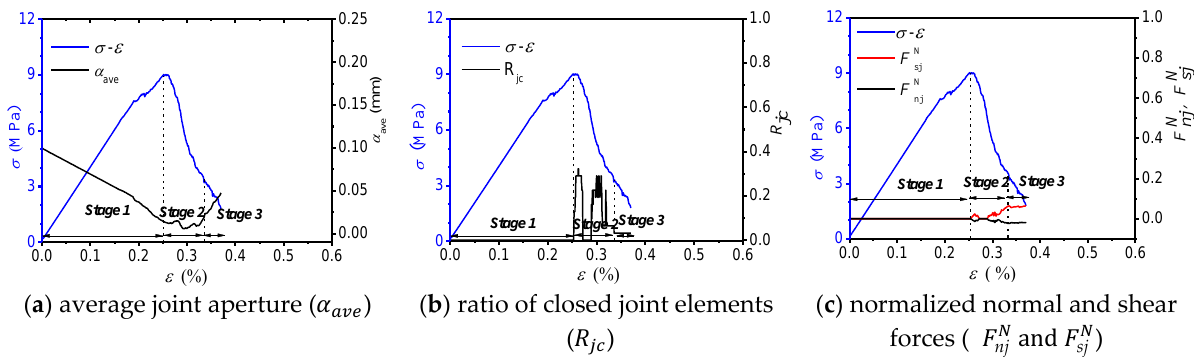
Figure 11. Evolution of the parameters of the joint system with increasing axial strain ( 𝛽 =30°).